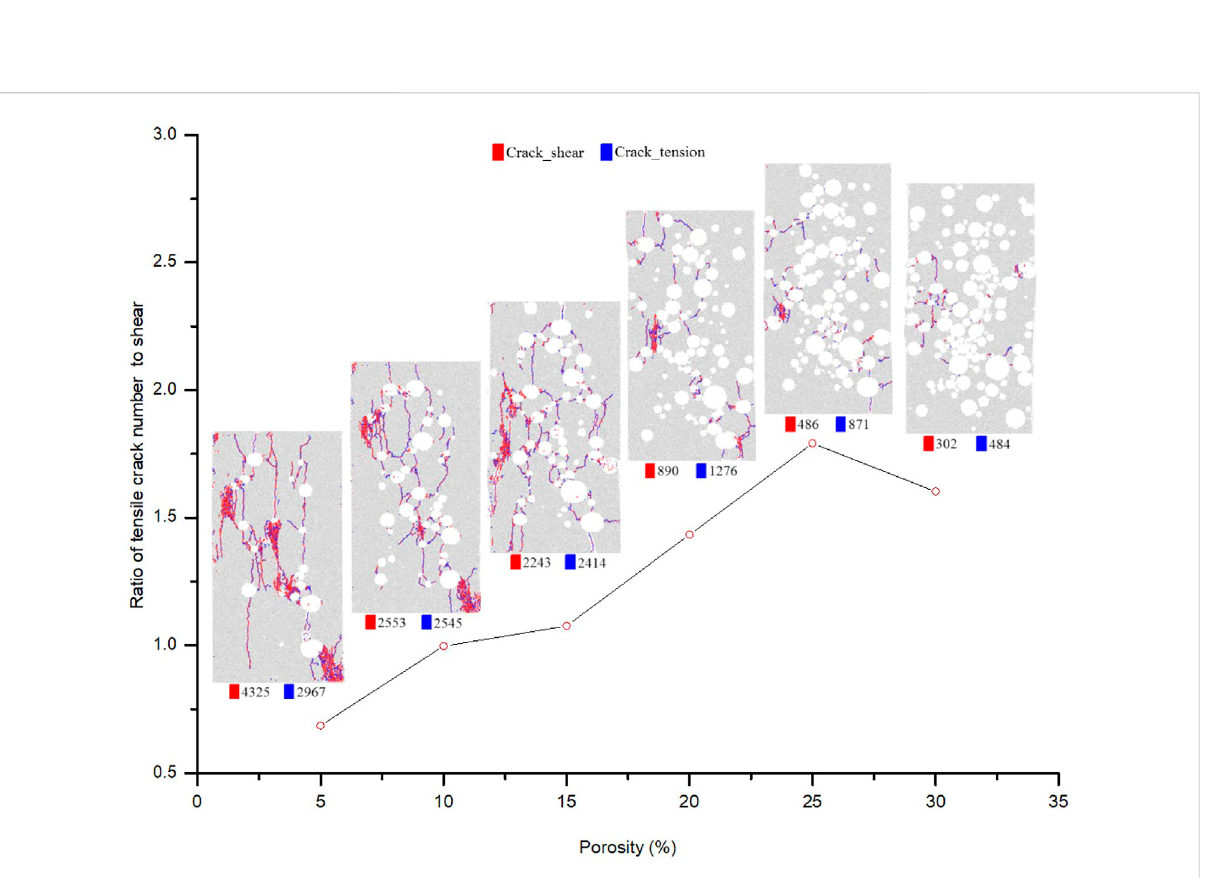
Crack distribution of the failure models with increasing defect